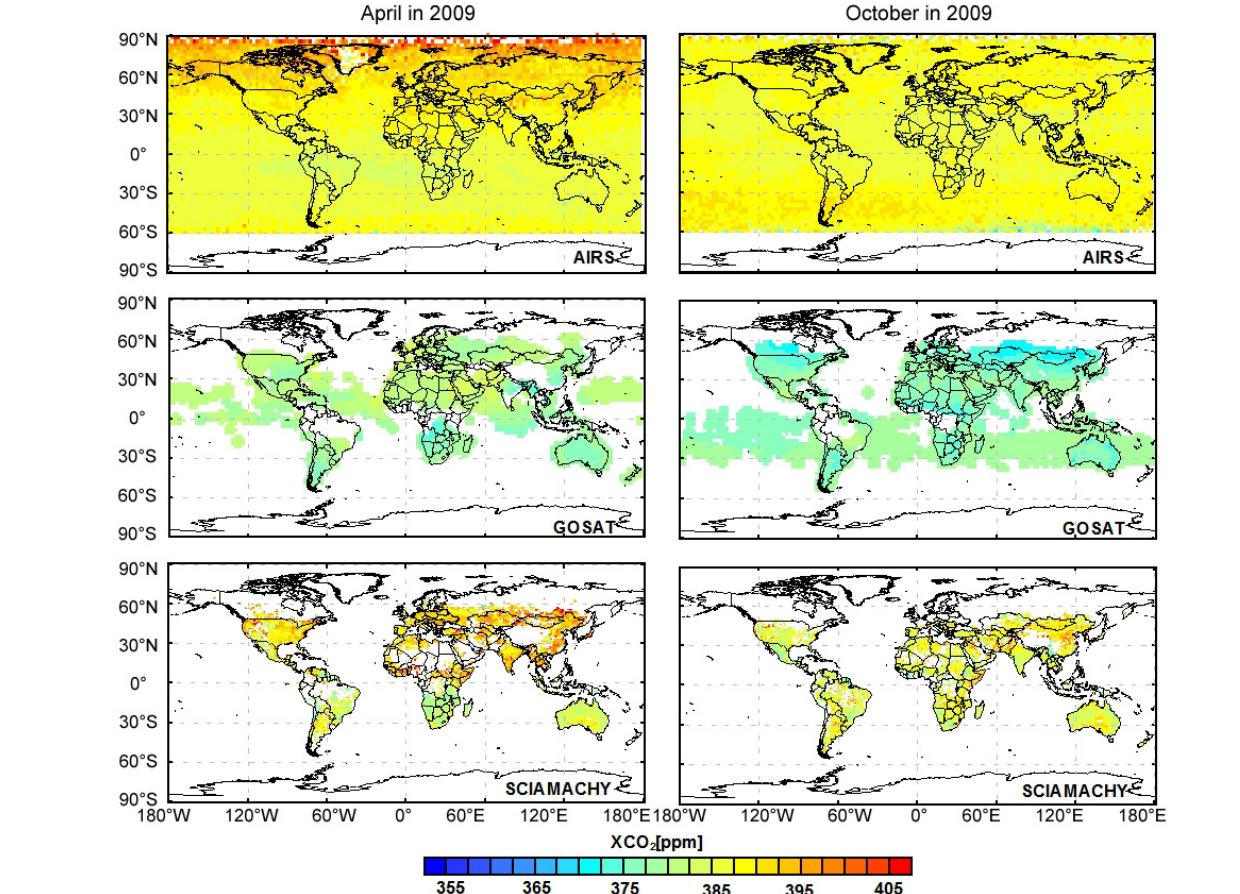
Figure 1. The global XCO concentration distribution retrieved from AIRS, GOSAT and 2 SCIAMACHY in April 2009 and in October